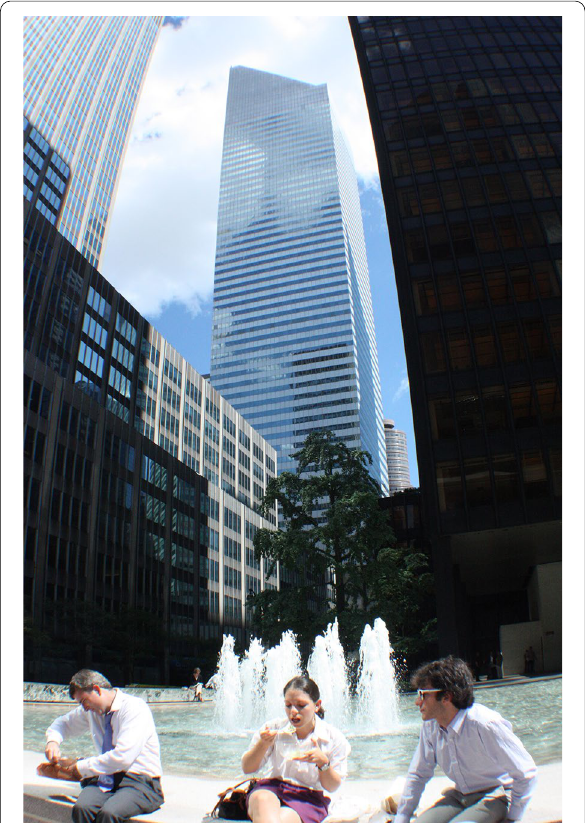
Fig. 26 One Madison in New York is composed of self-supporting cubes